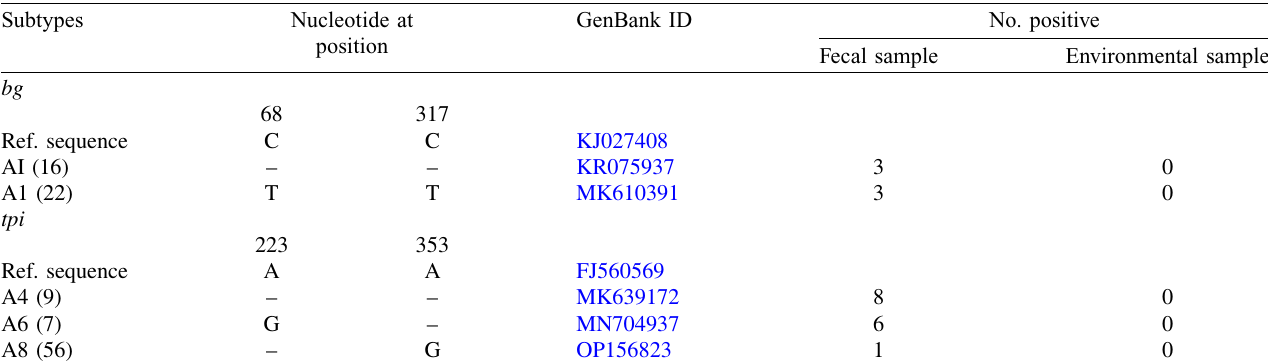
Table 4. Intra-assemblage substitutions of assemblage A at the bg and tpi loci.